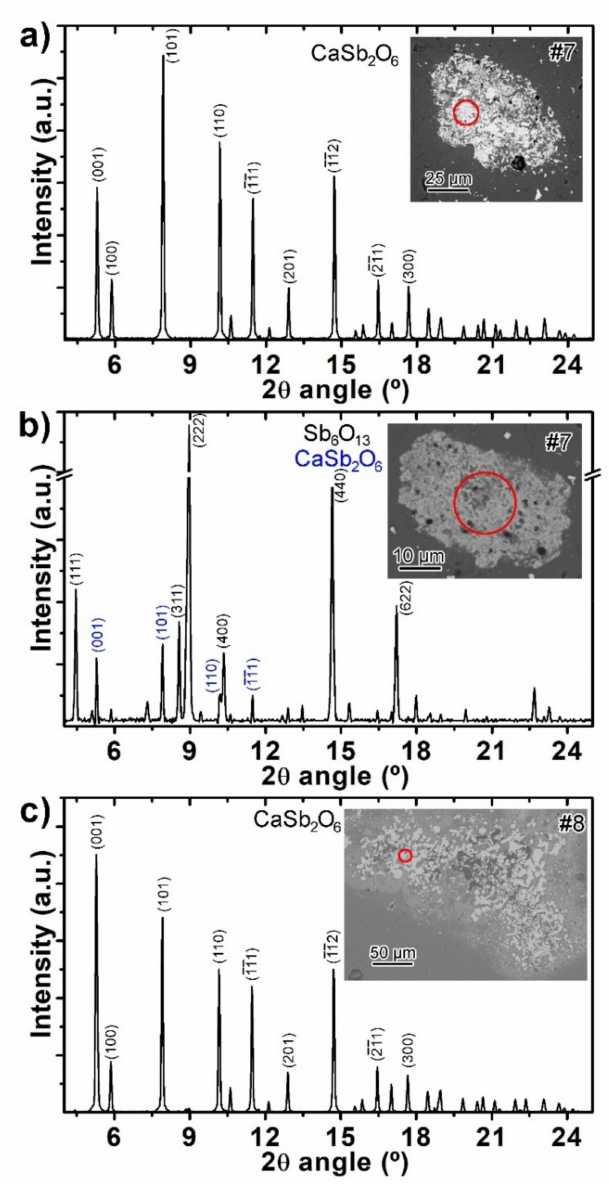
Figure 10. Representative diffractograms obtained by SR tts- µ XRD from the crystal aggregates found embedded within glass matrix of the bluish tesserae: ( a ) CaSb 2 O 6 pattern from an aggregate from tessera #7; ( b ) pattern showing peaks of Sb 2 O 13 and minor CaSb 2 O 6 from a clod relict from tessera #7; ( c ) CaSb 2 O 6 pattern from an area of the big aggregate from tessera #8. Corresponding SEM images with indication of the irradiated area (red circle) are also